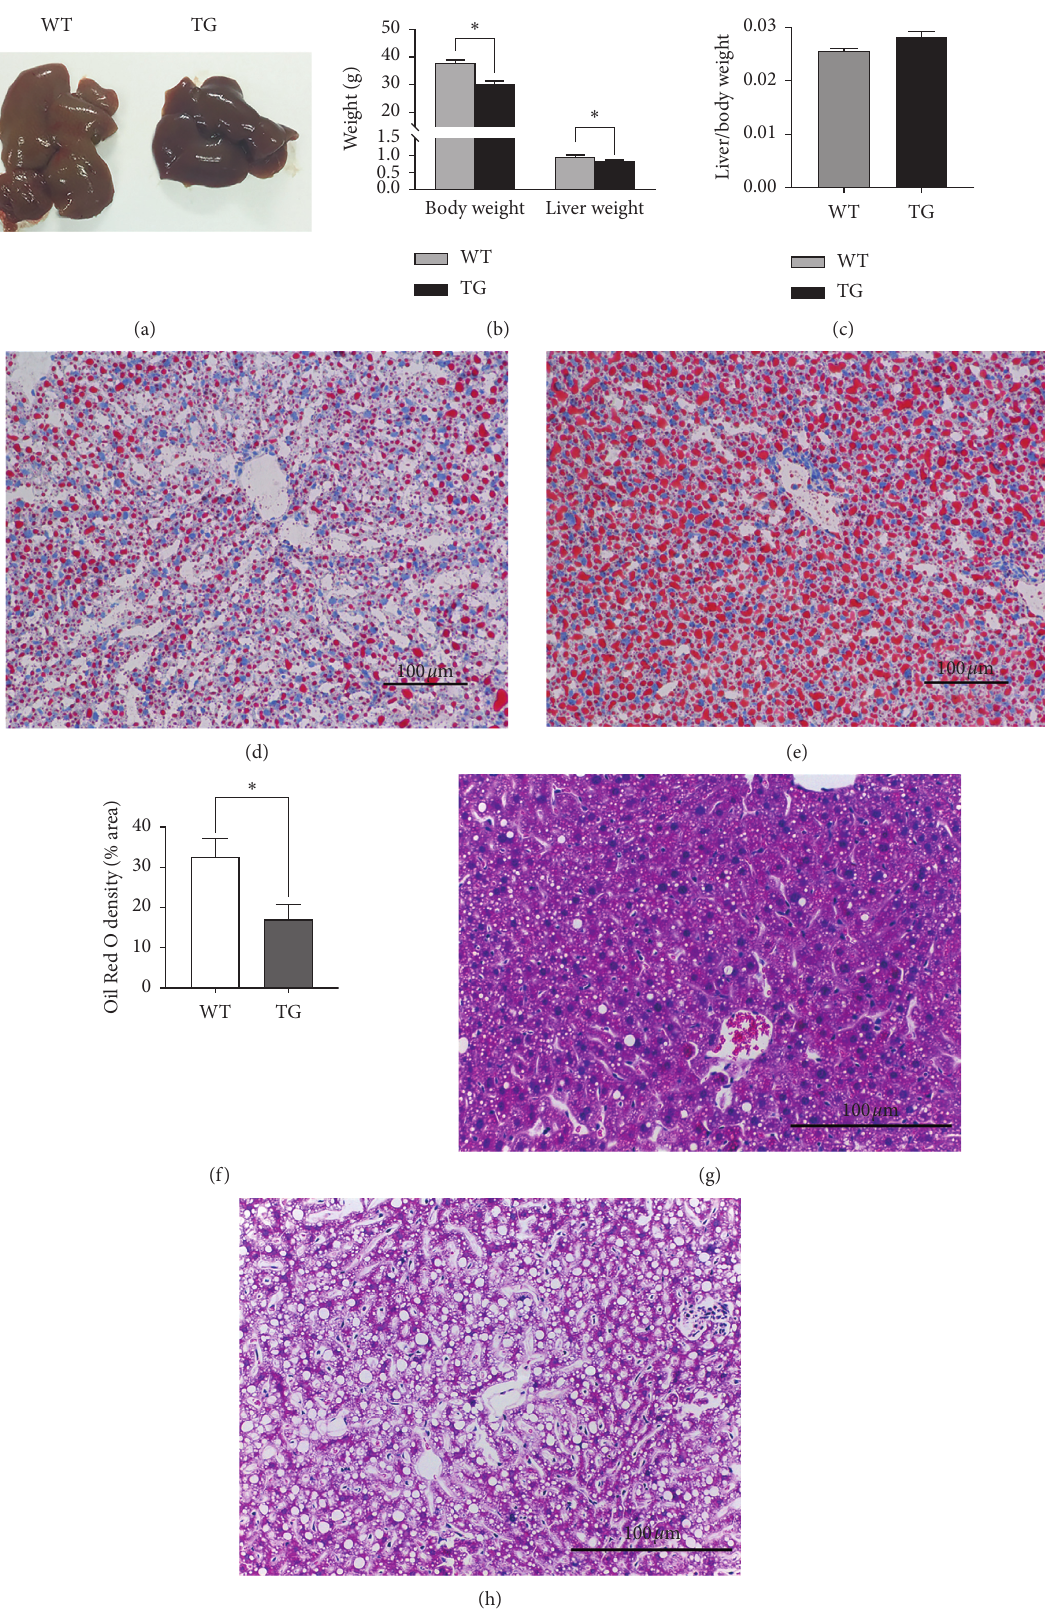
Figure 1: Morphological changes in the livers of GDF5 transgenic (TG) mice after HFD feeding for 10 weeks. (a) Comparison of liver sizes in TG mice and WTmice. (b) Body weights and liver weights of TG and WTmice. (c) Normalization of liver weight to body weight of TG and WT mice. (d) Oil Red O staining of TG mouse livers (scale: 100 μ m). (e) Oil Red O staining of WT mouse livers (scale: 100 μ m). (f) Quantitative analysis of lipid droplets in hepatocytes. (g) HE staining of TG mouse livers (scale:100 μ m). (h) HE staining of WTmouse livers (scale: 100 µ m) ( ∗ : P < 0 . 05; ∗∗ : P < 0 .